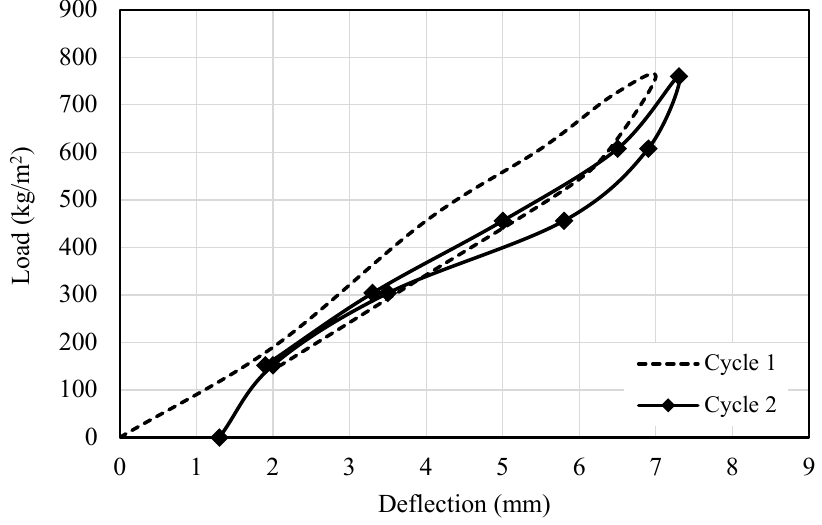
Figure 12. Overview of the loading and unloading process (Cycle 1 and Cycle 2).